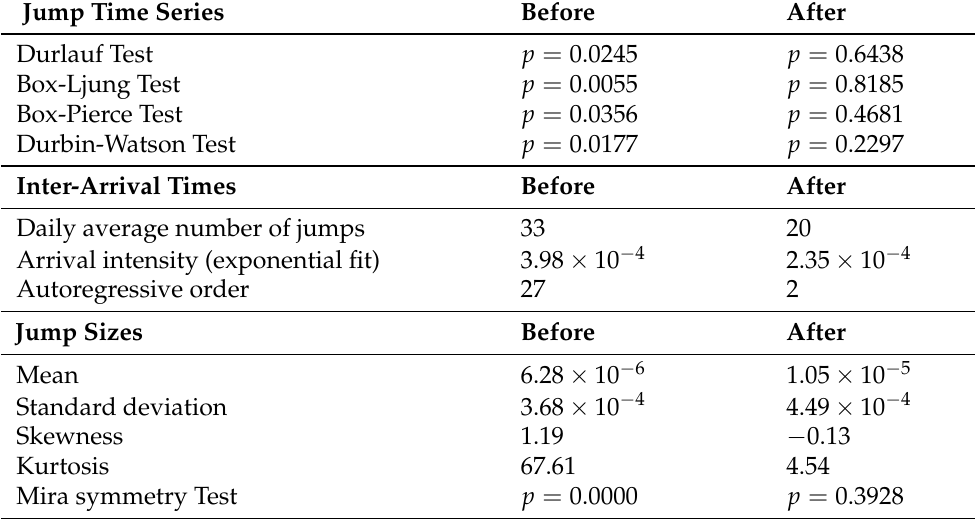
Table 1. Jump Component of EUR/USD Process Before and After Tick Size